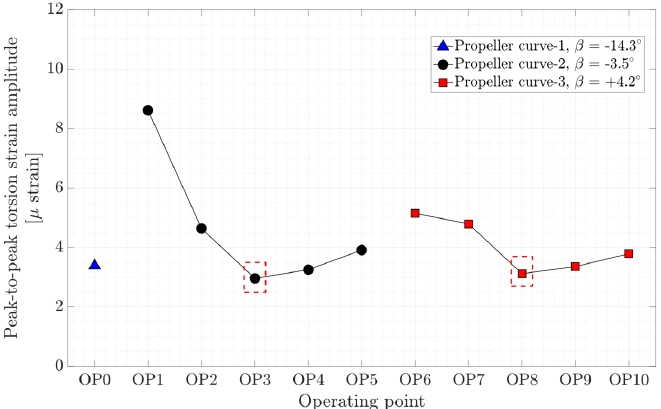
Figure 12. Peak-to-peak amplitude of axial strain obtained on the shaft at OP0–OP10 red dashed-line boxes indicate the on-cam operating points.